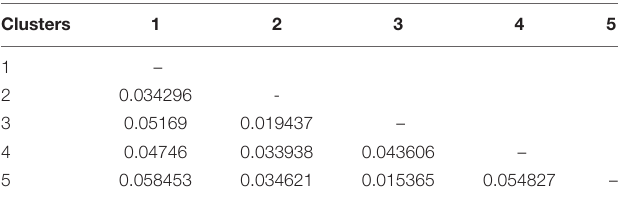
TABLE 1 | Pairwise coefficients of population differentiation ( F ST ) between the five clusters of the genome-wide association study (GWAS) panel inferred from the dendrogram from the kinship matrix ( Figure 1